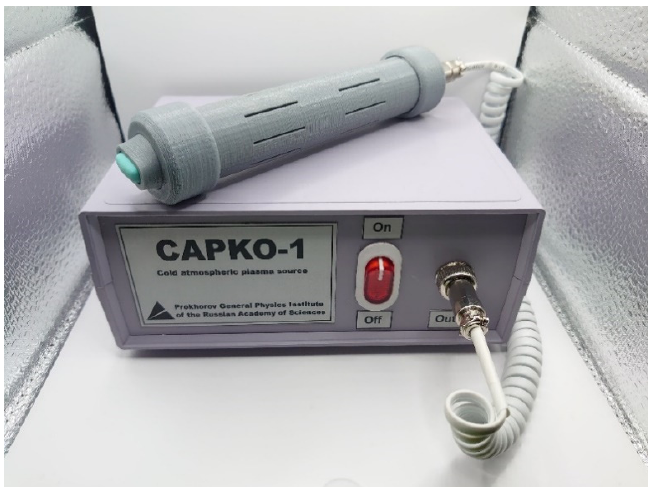
Figure 1. Photo of the “CAPKO” device for a CAP generation. Table 1. Physicochemical characteristics of PTS obtained from 10% NaCl solution after 45 min of